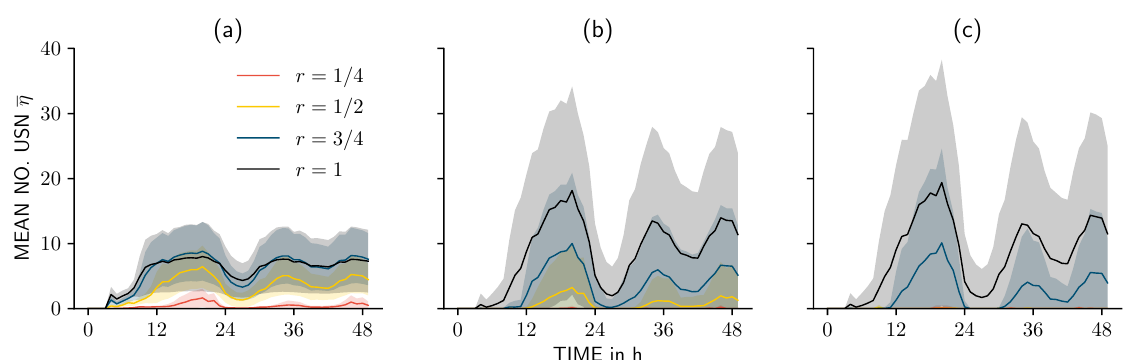
Figure 3. Mean and standard deviation of number of under-serviced nodes (USN) η for all evacuation radii r : ( a ) textitcen- tralized sheltering scheme, ( b ) near-at-hand sheltering scheme, ( c ) diffuse sheltering